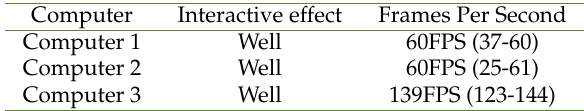
Fig. 13. Models displayed on computers with different configurations Table 10. Test results for different computer